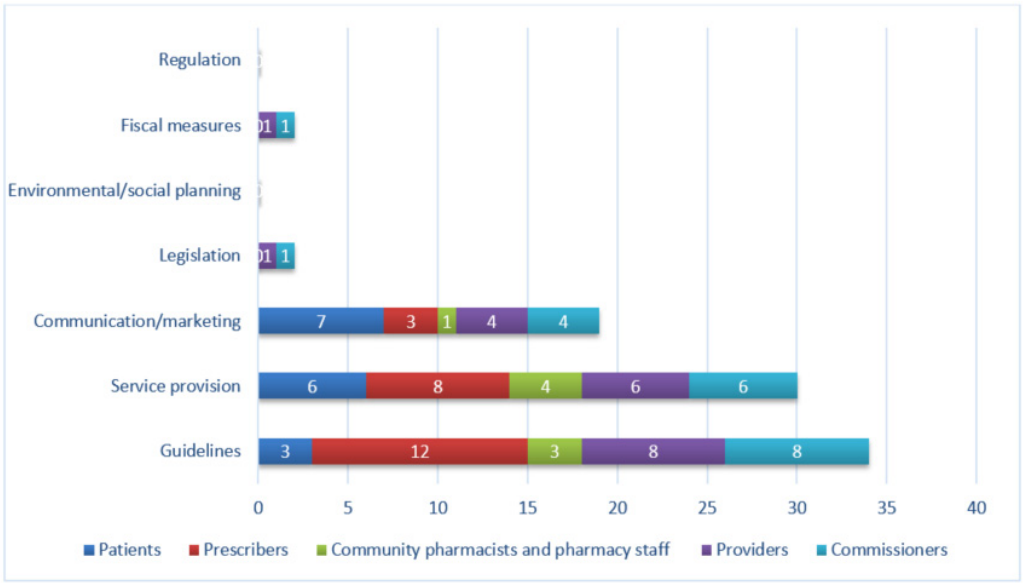
Figure 2. Frequency of identification of policy options, by target group. Total count will exceed the maximum number of interventions ( n = 39) as many interventions were aimed at more than one target group.